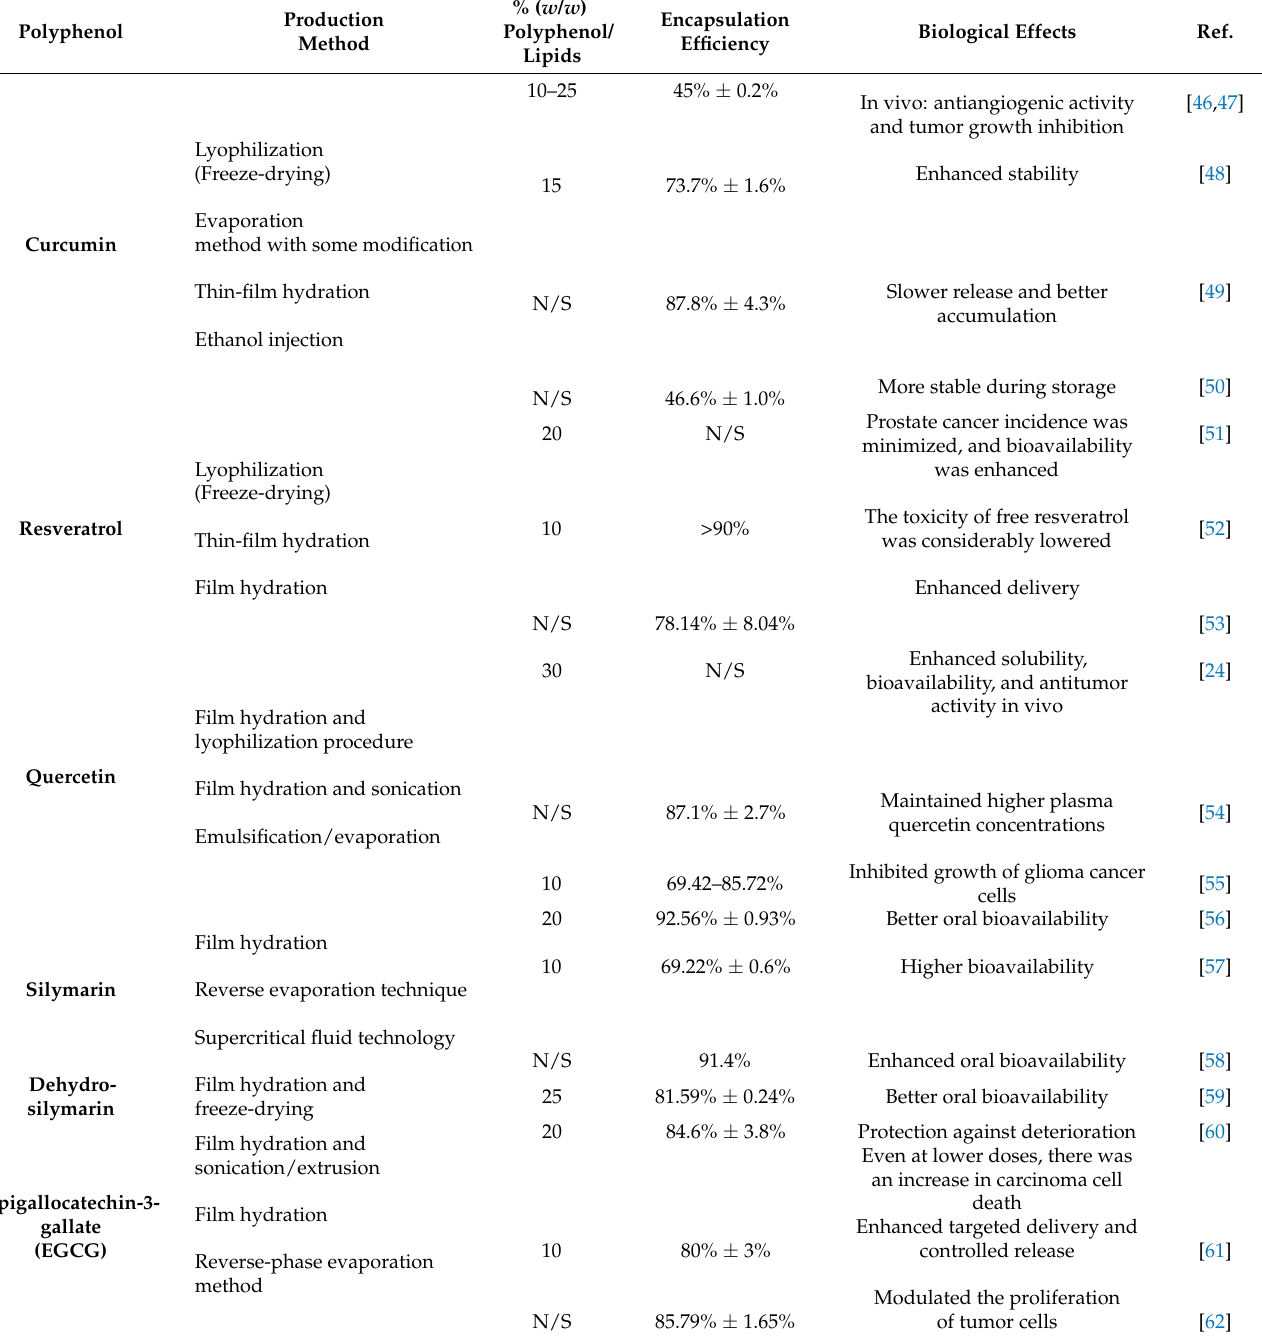
Biological Effects